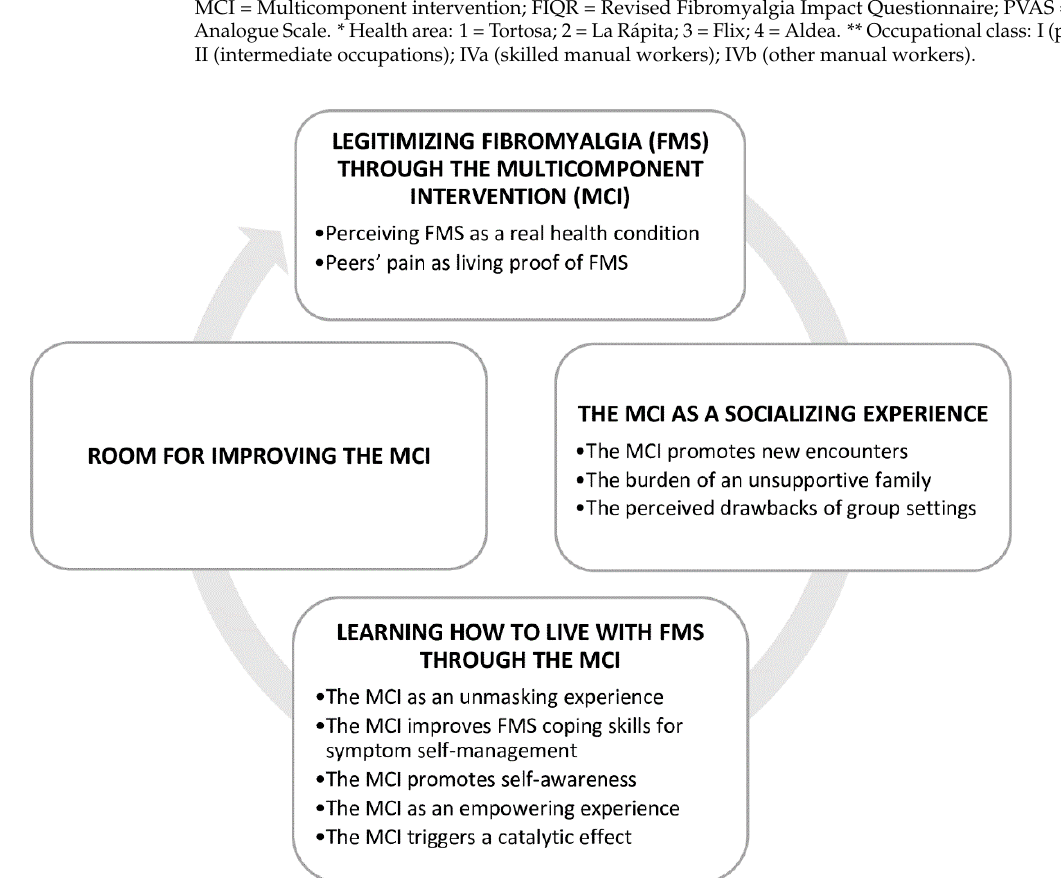
Figure 2. Themes and categories figure. In this regard, informers described hopelessness when their proprioceptive experience is overlooked by the biomedical field and the social network. Further discernment revealed how patients could have undergone emotional dejection, confusion, and doubts regarding their suffering, which led to a nihilistic attitude towards themselves and the healthcare services. While existing treatment strategies are essentially based on pharmacological symptom control and lifestyle changes, patients may not be willing to make any effort if they do not perceive their condition as a real and frequent health problem that